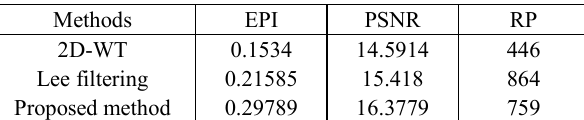
Table 2. Evaluation index values acquired from three de- noising